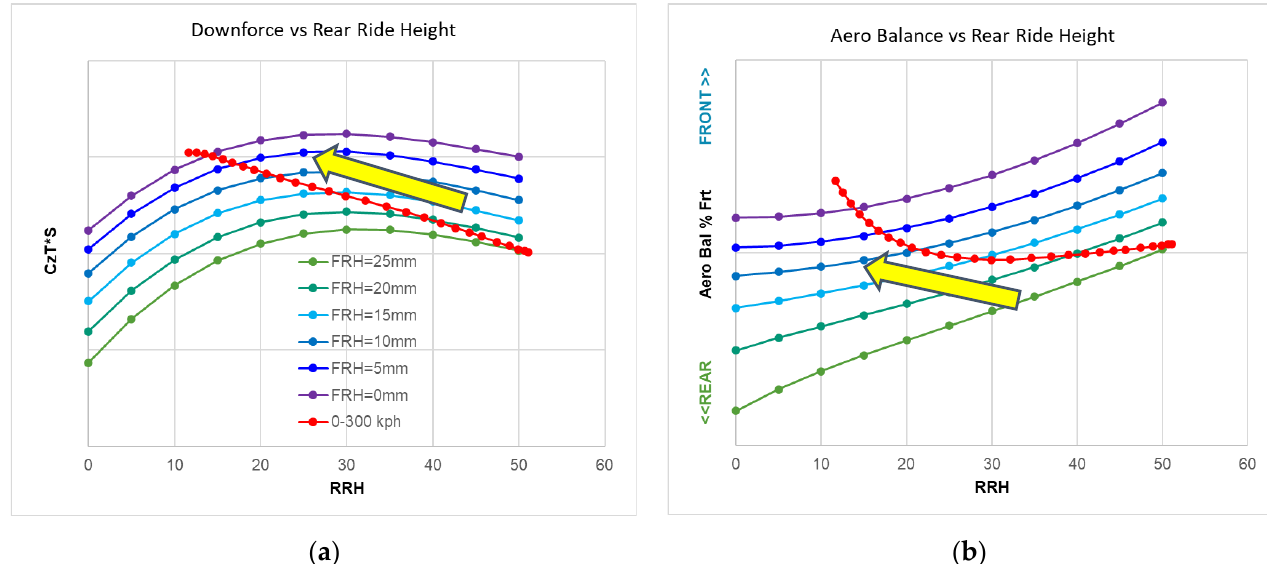
Figure 13. Aero maps plotted as: ( a ) Downforce vs. Rear Ride height; ( b ) Aero Balance vs. Rear Ride Height, for various Front Ride Heights. These graphs highlight non-linear sensitivity to both front and rear ride heights hence to heave and pitch. The evolution in the 0 – 300 kph range is shown in red. Yellow arrows indicate increasing speed.